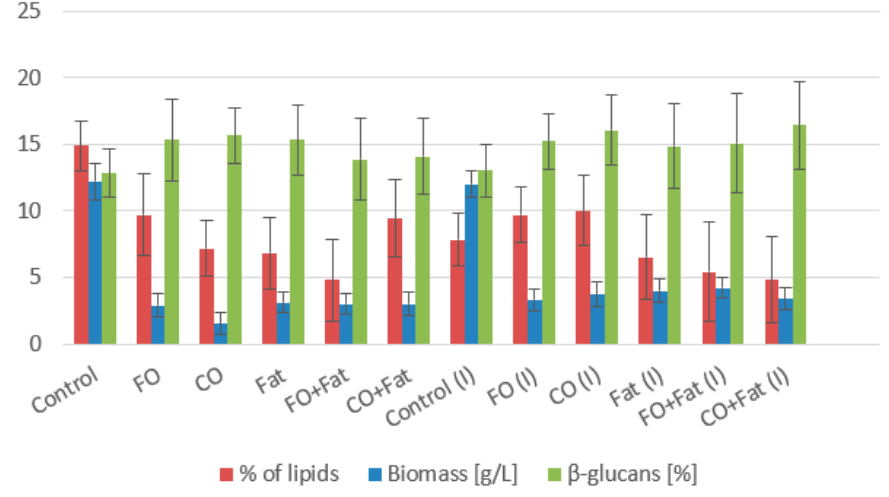
Figure 7. Phase II: Biomass, lipid, and β -glucan production of Rhodotorula toruloides cultivated on waste lipid media with and without lipase induction.